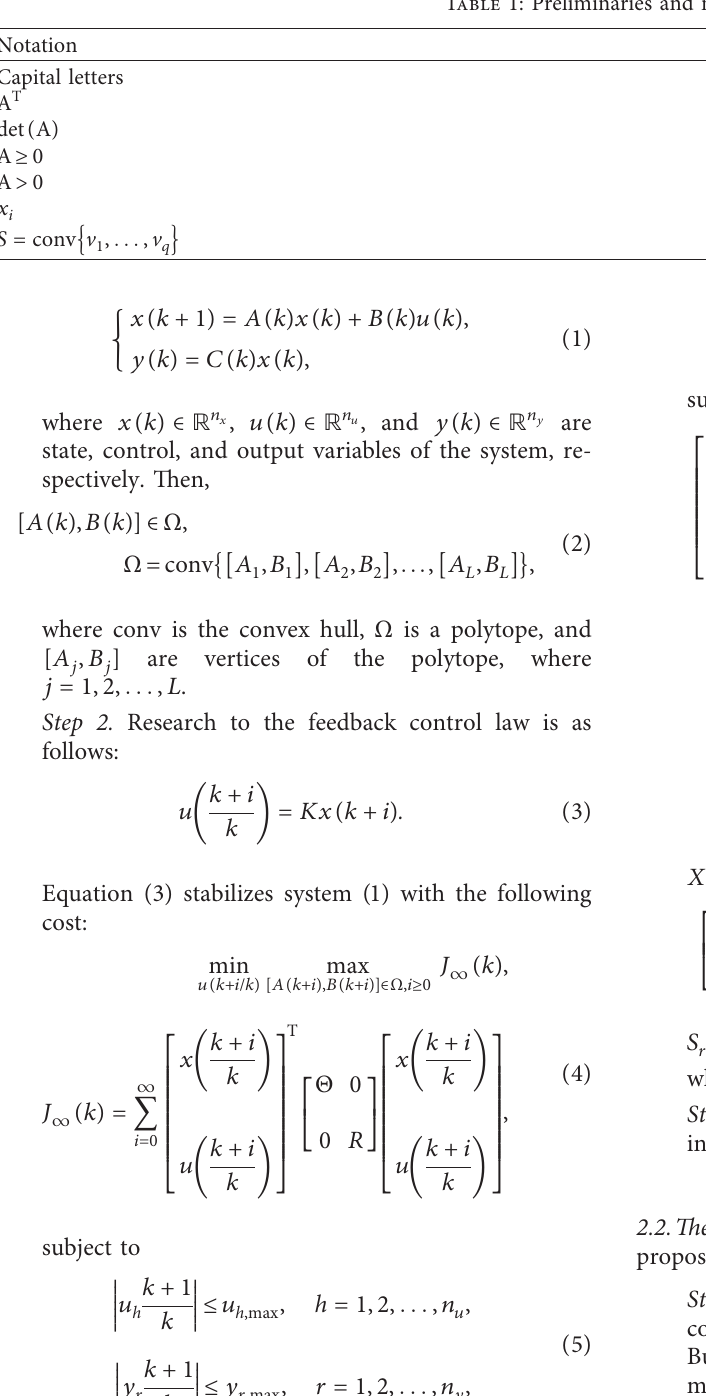
Table 1: Preliminaries and